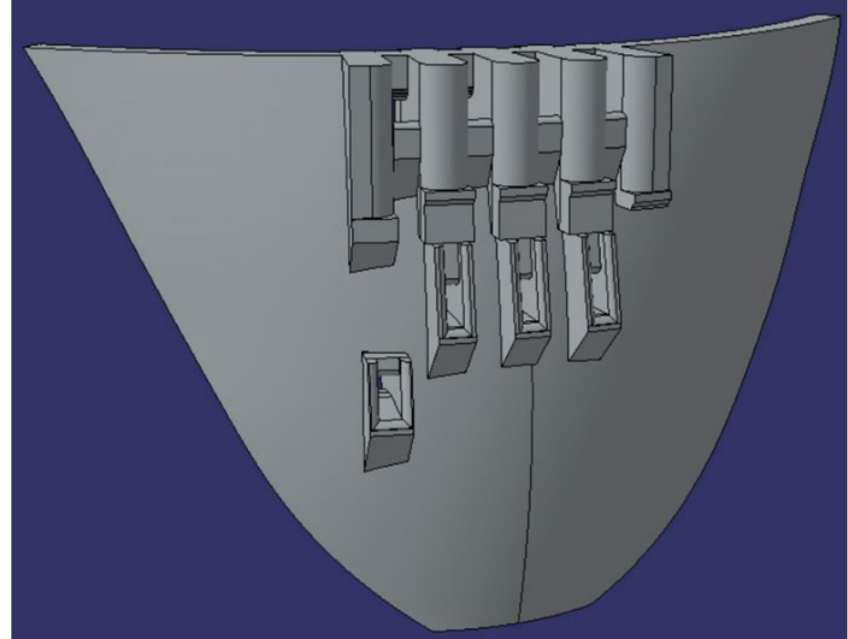
Figure 6. Three-dimensional model of the Y2 Arch dam. (2) Figure 7 is the three-dimensional model of the Y2 RCC gravity dam. The concrete volume of the gravity dam is 3.27 × 10 6 m 3 with 15 dam monoliths. The dam body has 4 discharge surface holes and 3 middle